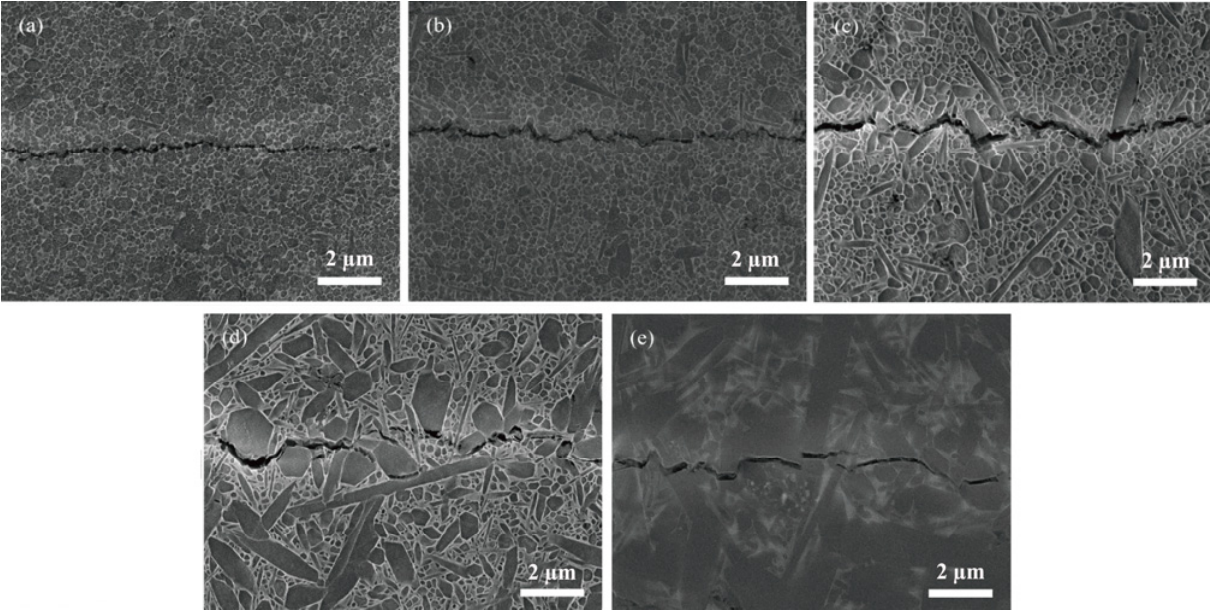
Fig. 7 SEM images of crack propagation paths in Si 3 N 4 ceramics: (a) SN1500, (b) SN1600, (c) SN1650, (d) SN1700, and (e)